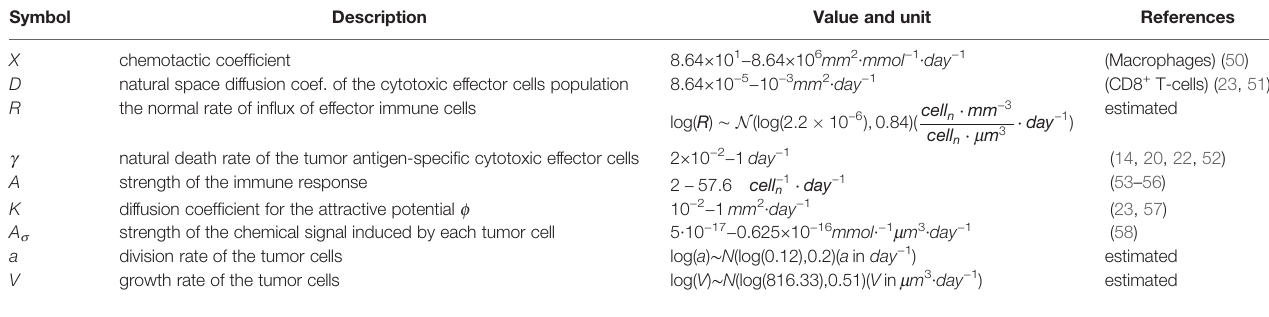
TABLE 1 | Key model parameters and their biophysical meaning. Symbol Description Value and unit